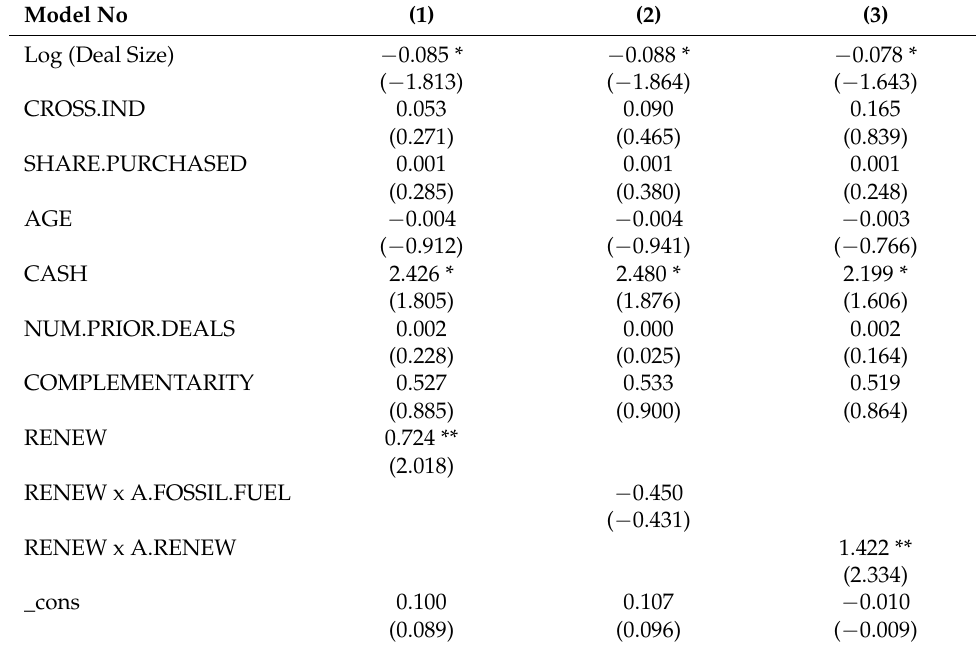
Table 8. The likelihood of positive post-transaction